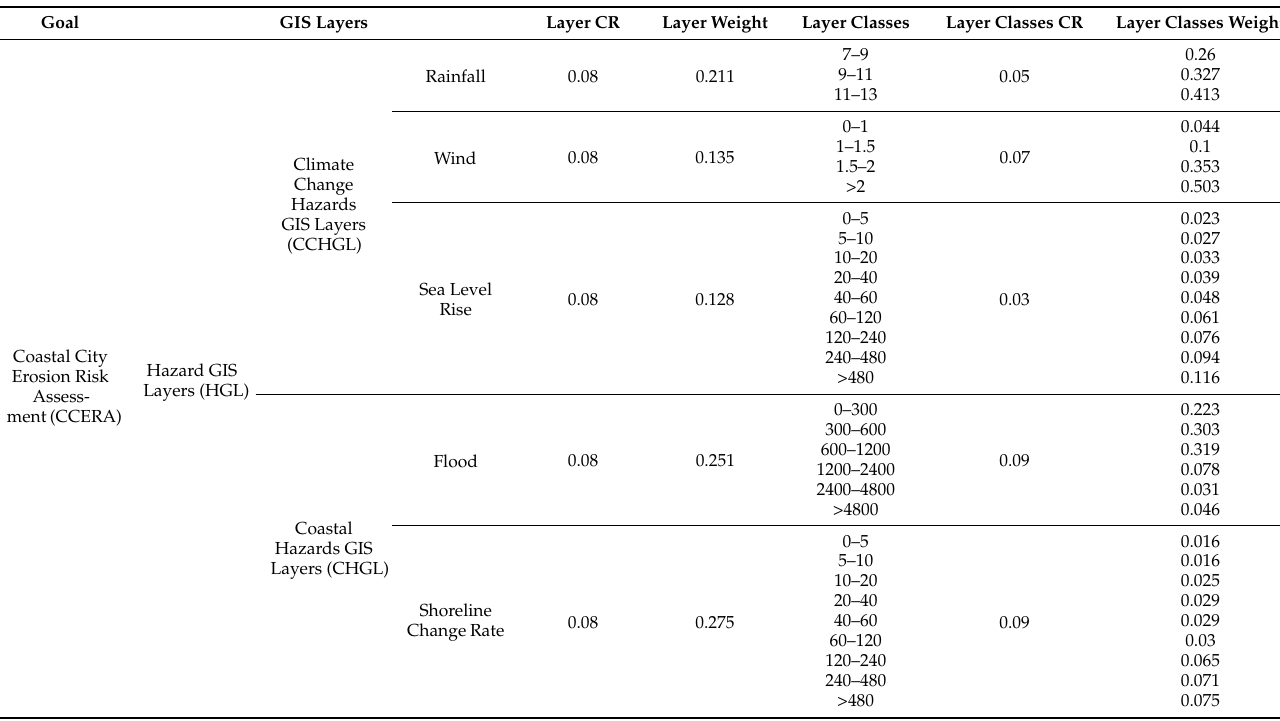
Figure 4. Final hazard map and sensitive zones. Table 4. Hazard GIS layers class and weights.